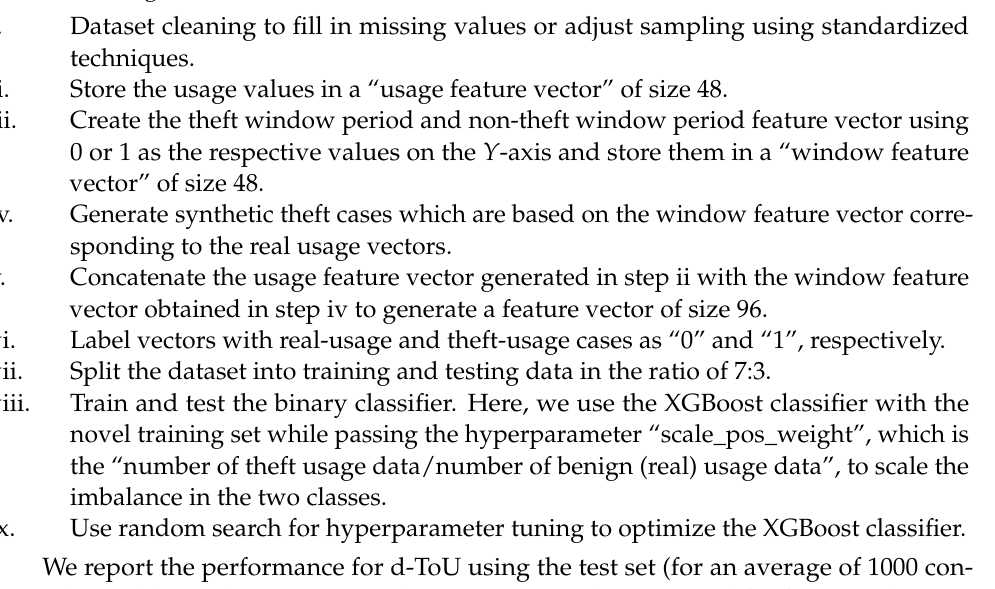
Figure 4. Novel concatenation data processing in the DETD algorithm.